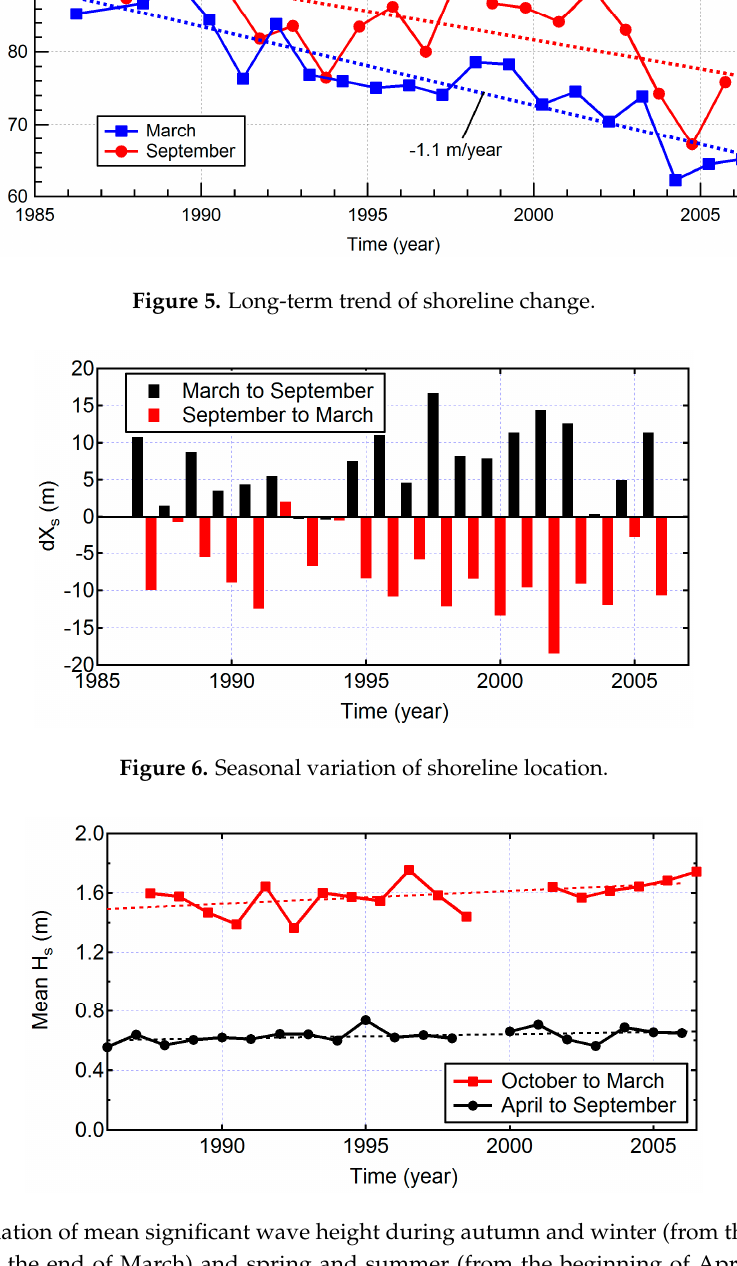
Figure 7. Variation of mean significant wave height during autumn and winter (from the beginning of October to the end of March) and spring and summer (from the beginning of April to the end of September).